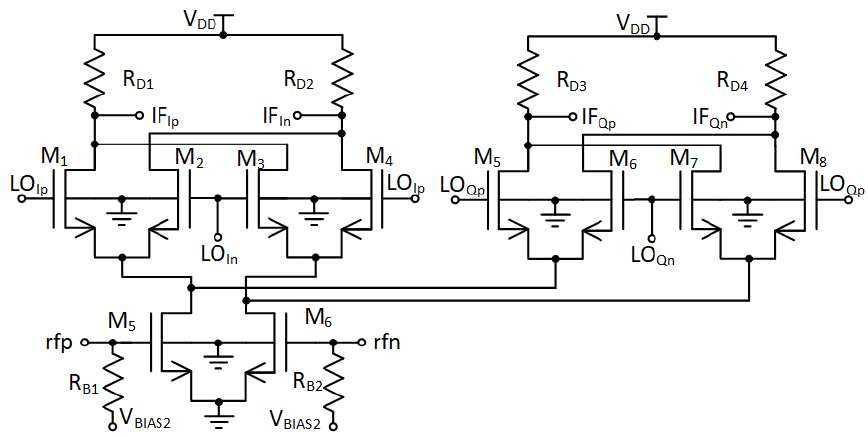
Figure 7. Schematic diagrams of double-balanced quadrature Gilbert mixer.